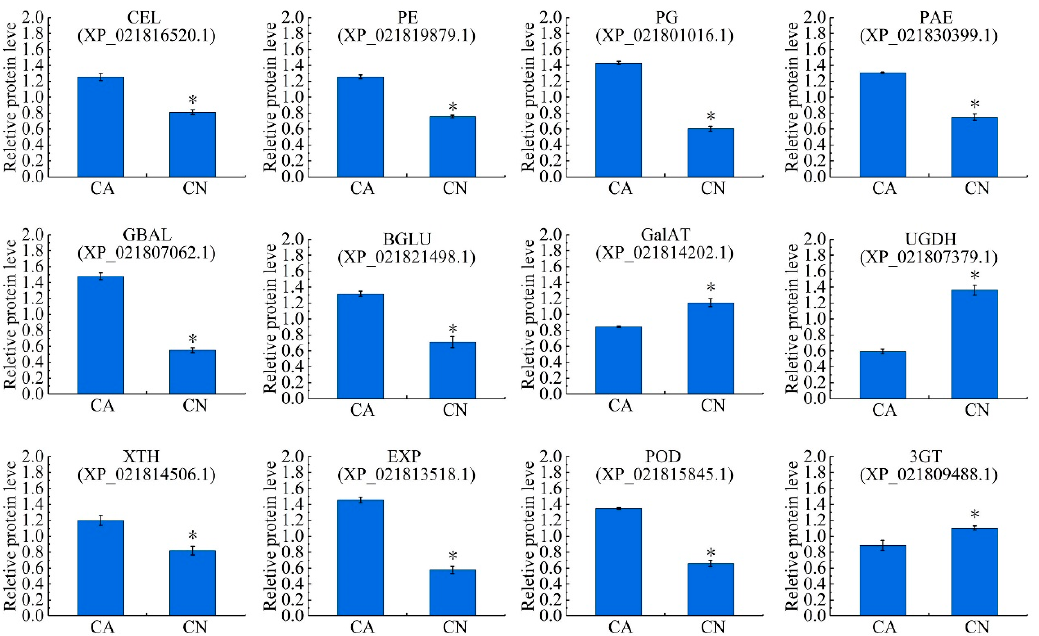
Figure5. Relativeexpressionlevelsoftheproteinsrelatedtocellwallmetabolismandligninbiosynthesis. Figure 5. Relative expression levels of the proteins related to cell wall metabolism and lignin Significant di ff erences in expression level were indicated by biosynthesis. Significant differences in expression level were indicated by “*”.